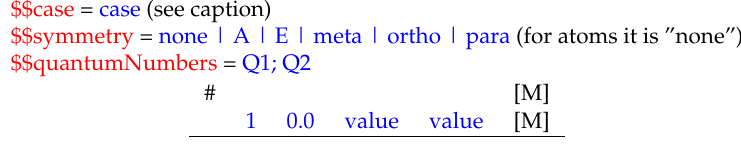
Table A3. Template of an “Energy origin” section input as requested by the import script. The metadata are in red and the values in blue. The “case” metadata are dcs | hunda | hundb | ltcs | nltcs | stcs | numbers. Both the case and the quantum numbers are described in the case-by-case document (http://www.vamdc.eu/documents/cbc-1.0/). In the second part of the table, all fields are mandatory. The logic of the numerical line is the same as in Table A2.